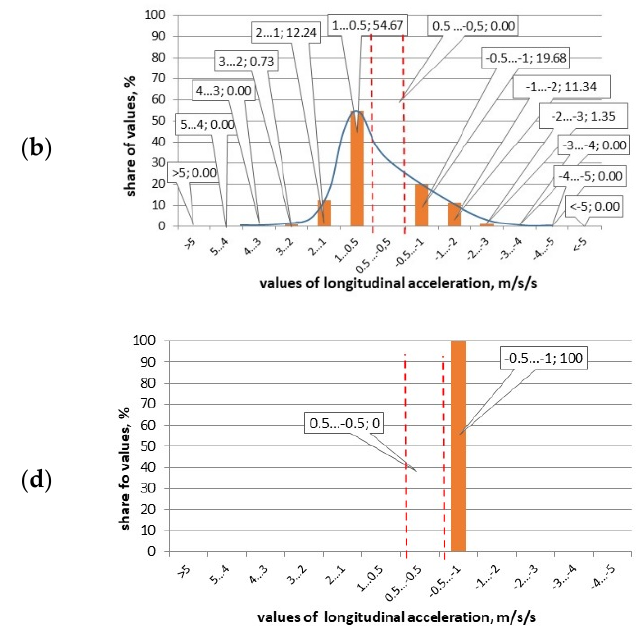
13 of 19 Figure 9. Lateral acceleration values excluding the ‘constant speed’ driving range on various road types: ( a ) urban area (city); ( b ) non-urban area (single roadway with two traffic lanes); ( c ) two- roadway expressway; ( d ) motorway. Based on the charts presented in Figures 10 and 11, it is possible to evaluate the struc-